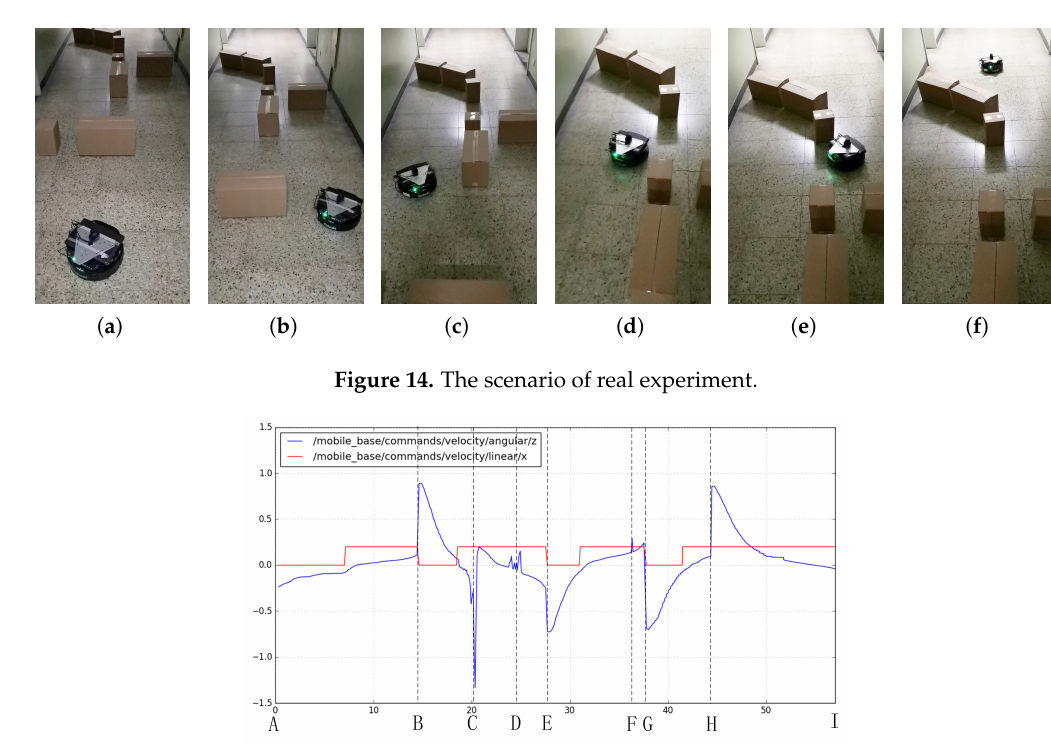
Figure 13. Turtlebot2.